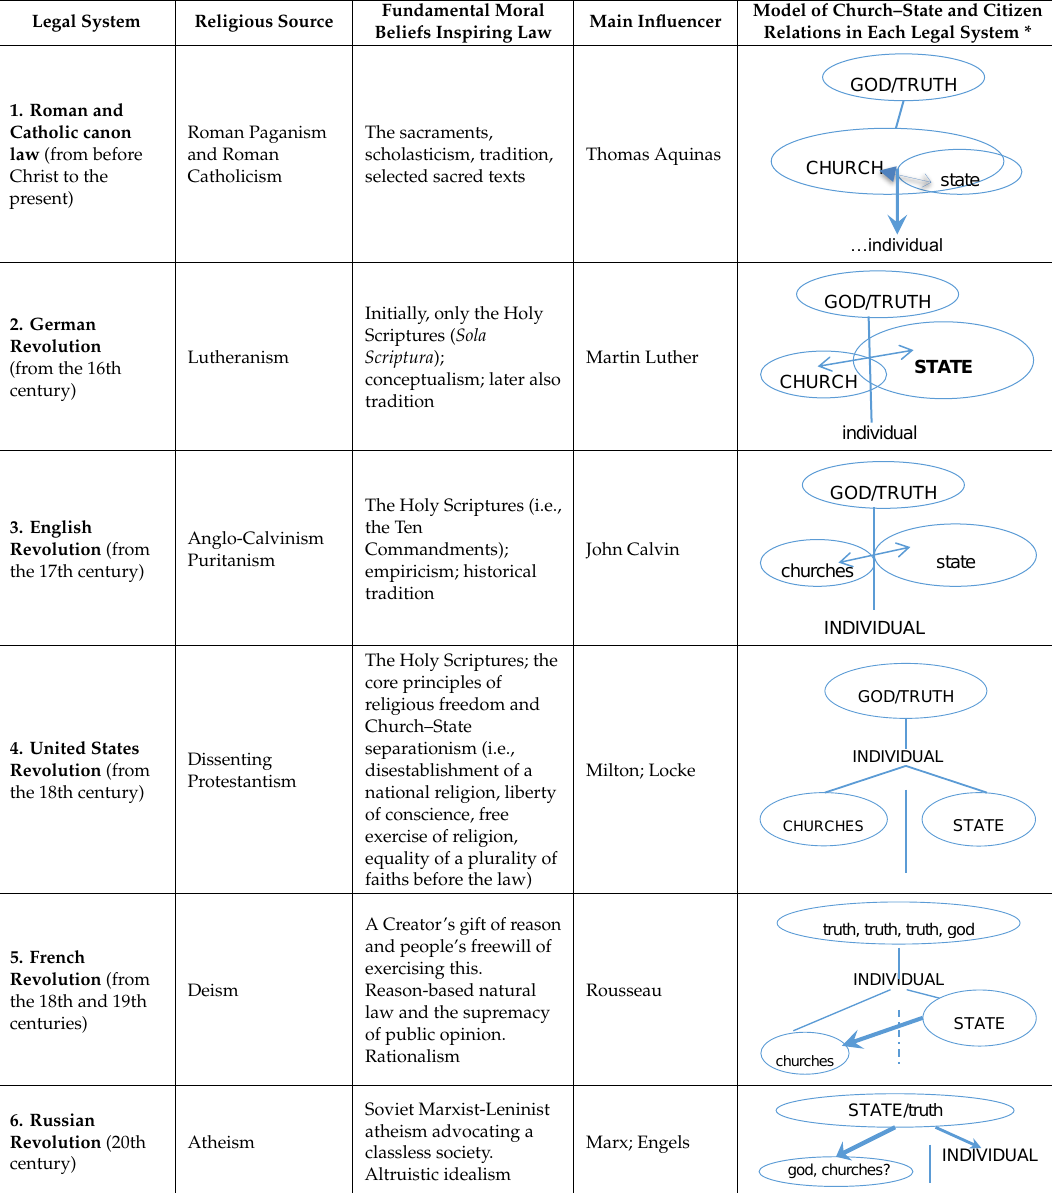
Table 6. Moral and religious beliefs and models of state–church-citizen relations in the legal systems of Europe and the Americas (adapted from Witte 2002; Berman 2003; Miller 2012; Cook 2012; Merryman and Pérez-Perdomo 2007).